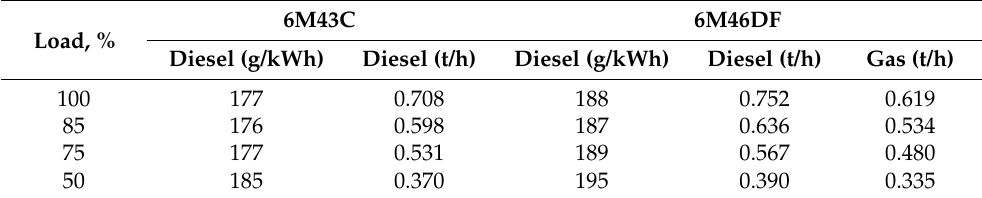
Table 4. Fuel consumption of 6M43C and 6M46DF